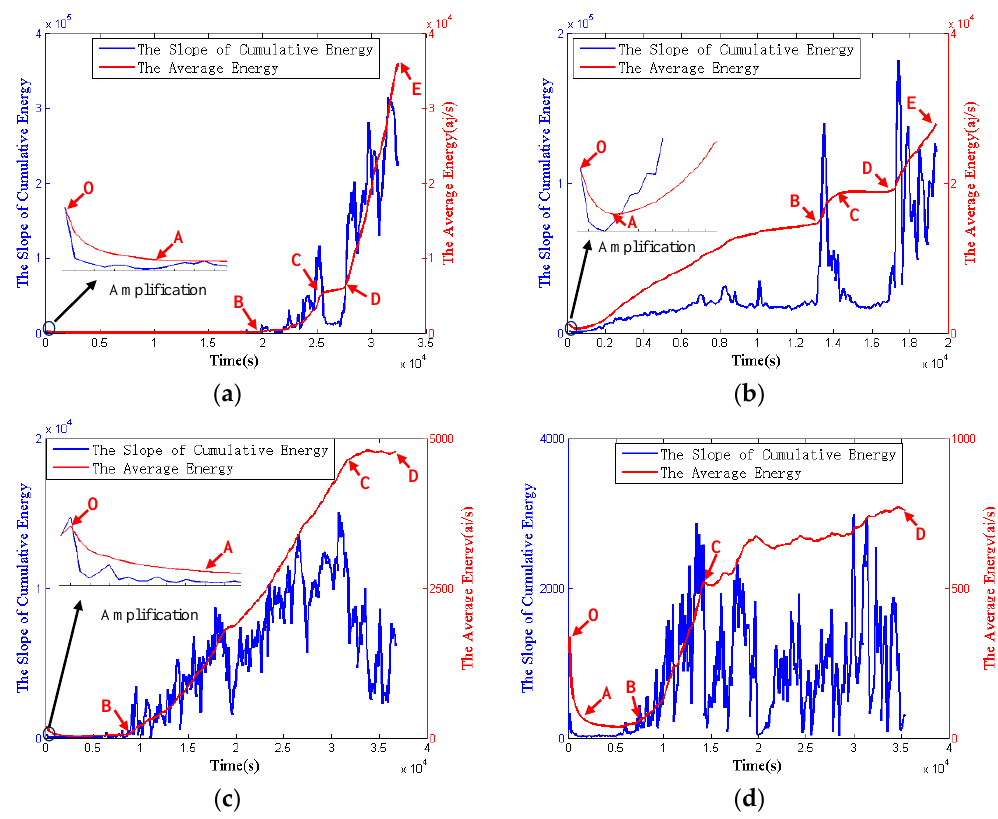
Figure 4. The cumulative energy and the slope of cumulative energy: ( a ) the first specimen; ( b ) the second specimen; ( c ) the third specimen; ( d ) the fourth specimen.